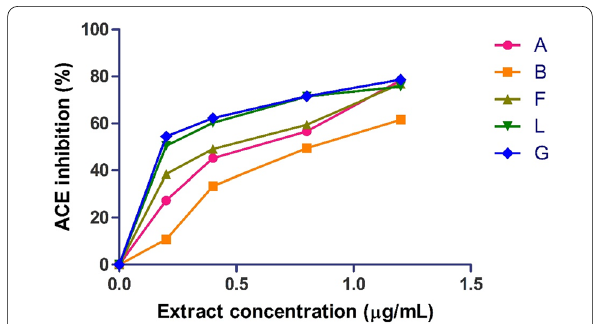
Fig. 4 Angiotensin-I-converting enzyme (ACE) inhibition of corn silk–lemon and commercial tea infusion. Angiotensin-I-converting enzyme (ACE) inhibition assay in corn silk–lemon and commercial tea infusion by a spectrophotometric method of Cushman and Cheung (1971). The substrate [Hippuryl-histidyl-leucine (Bz-Gly-His-Leu)] and ACE (EC 3.4.15.1) was obtained from rat penile tissue. The amount of cleaved hippuric acid from hippuryl-histidyl-leucine was measured by the enzymatic method. The absorbance of the mixture was measured at 228 nm. The control experiment was performed without the test sample and the ACE inhibitory activity was expressed as percentage inhibition and plotted against five samples extract concentration (ug/ ml). CSF: corn silk flour; LF: lemon flour; A: 100% CSF; B: 95% CSF and 5% LF; F: top tea; L: lipton tea; G: green